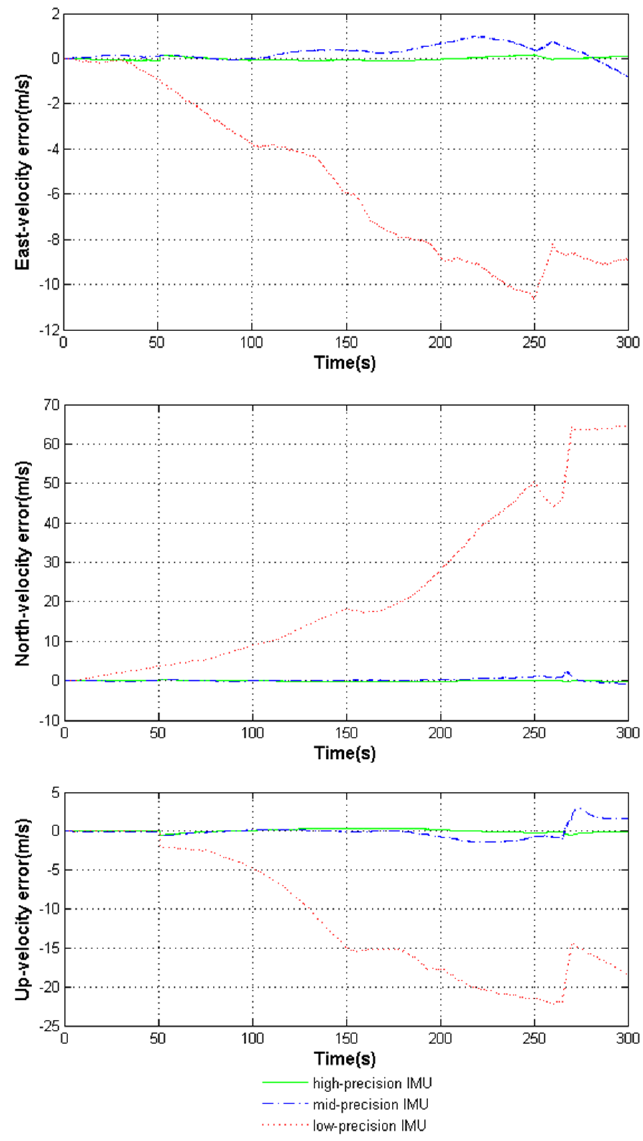
Figure 6. Comparison diagram of velocity error aided by the three kinds of IMUs.